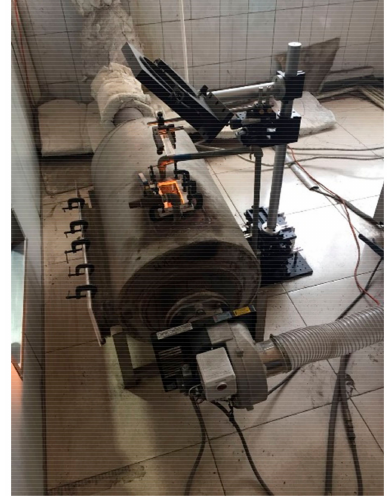
Figure 3. The boiler site